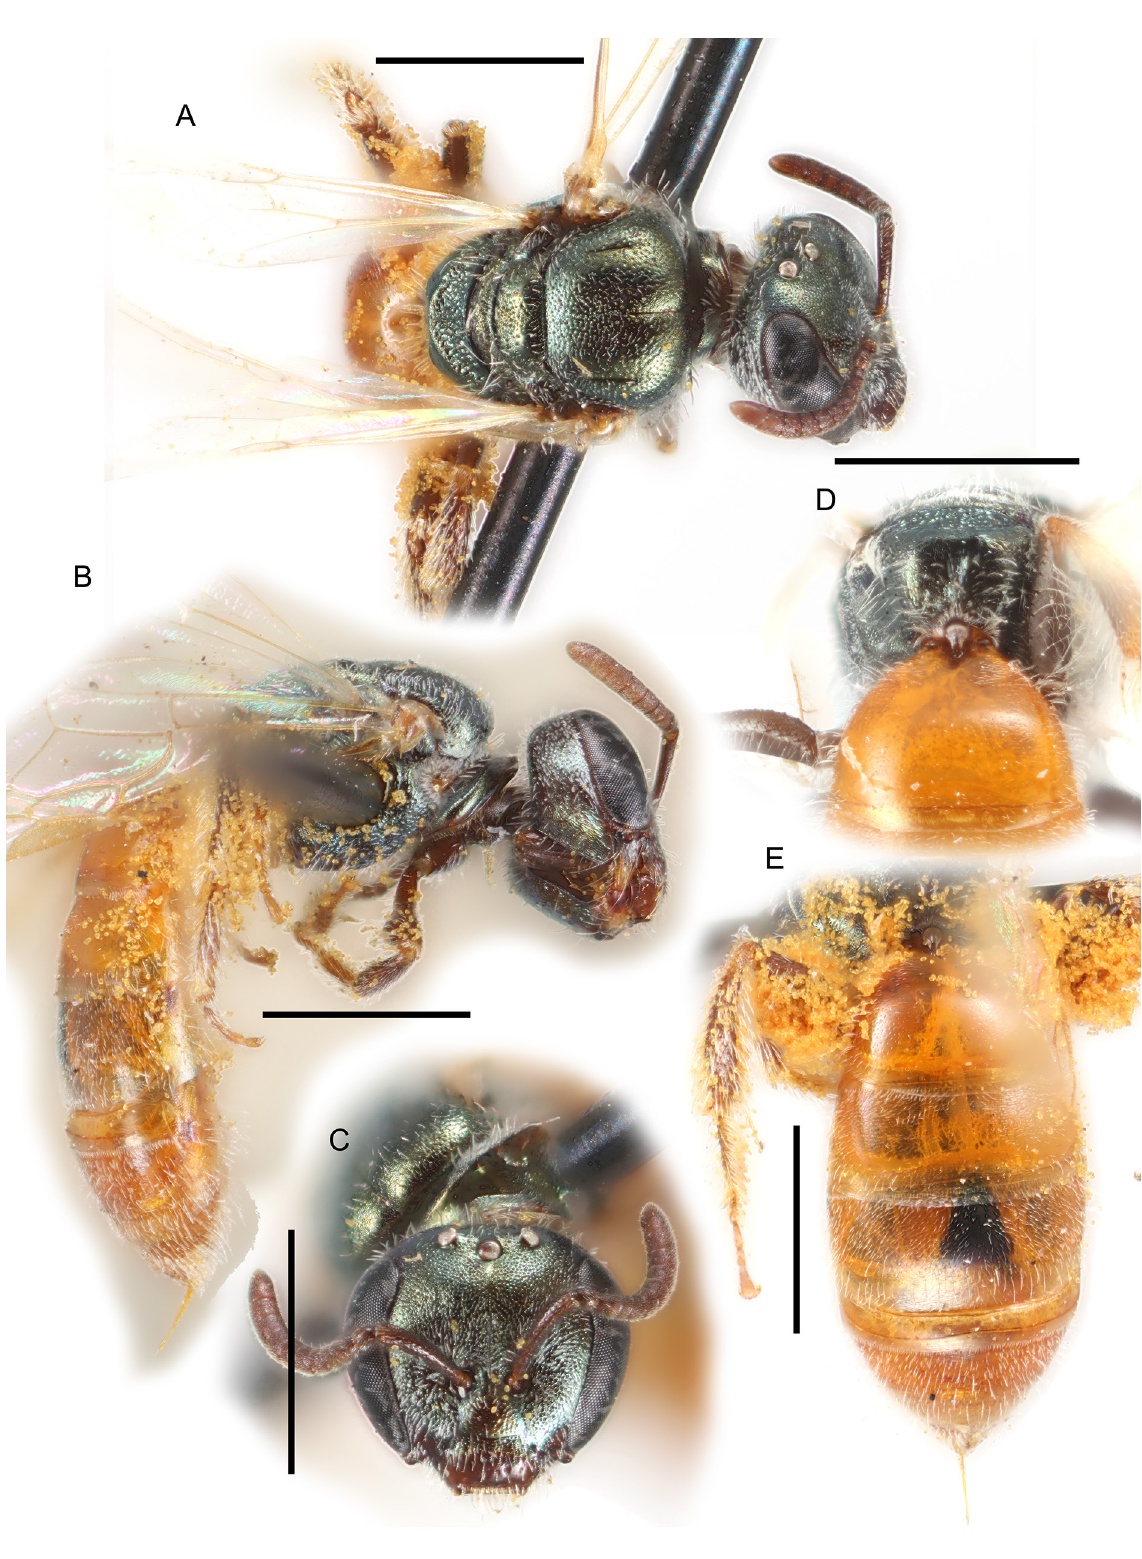
Fig. 28. Lasioglossum ( D. ) clematisellum (Cockerell, 1904), holotype, ♀ ( USNM 12064). A . Dorsal habitus. B . Lateral habitus. C . Face. D . Propodeum (not holotype). E . Metasoma. Scale bars: 1